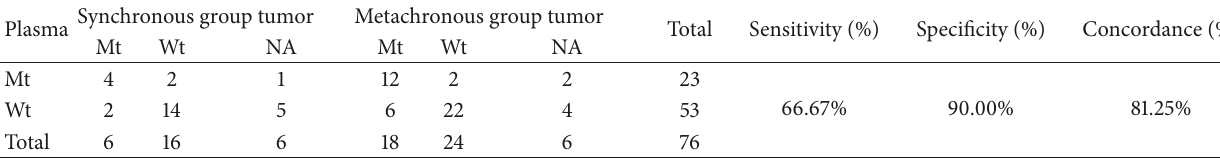
Table 3: Comparison of KRAS gene mutation in ctDNA and tumor